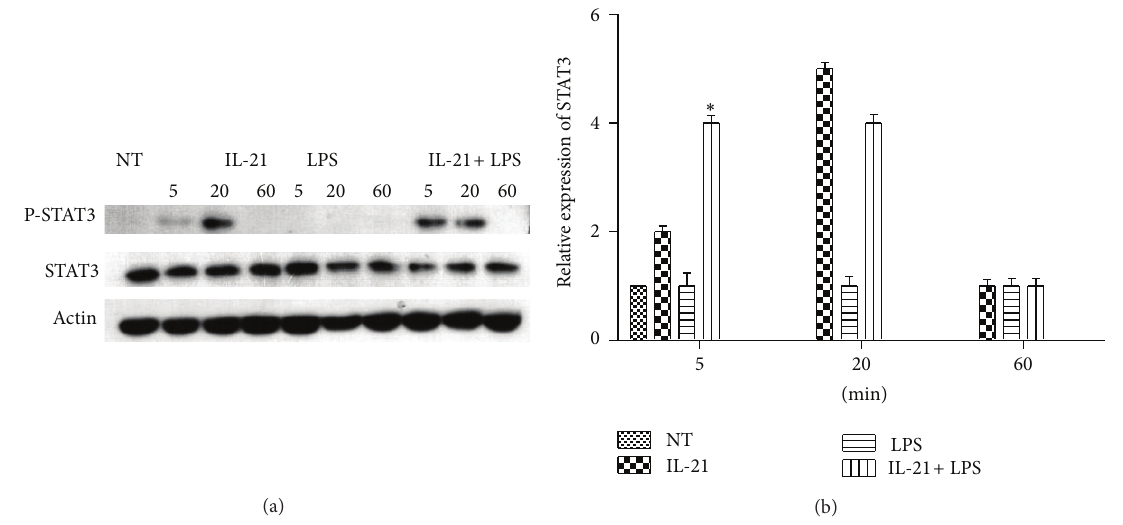
Figure 8: Effects of IL-21 on LPS-induced STAT3 signal pathway in mouse peritoneal macrophages. Macrophages ( 5 × 10 6 ) were incubated with IL-21 (100ng/mL) in the presence or absence of LPS (100ng/mL) for 5 min, 20 min, and 60 min. Cytosolic proteins from macrophages were analyzed by Western blot with specific antibodies. Detection of Actin was estimated as protein-loading control for each lane. Values are presented as mean ± SD of three independent experiments. ∗ 𝑃 < 0.05 compared with the LPS